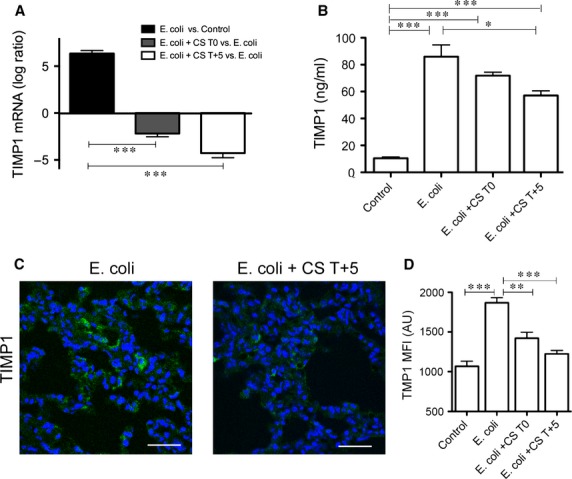
Compstatin inhibits sepsis-induced expression of TIMP1. (A) Log ratio qPCR data showing transcript regulation of TIMP1 by sepsis and complement inhibition. Expression values were normalized by housekeeping gene β-actin. Data are shown as mean ± S.E.M. of three replicates. One-way anova with Dunnett's multicomparison test; ***P < 0.001 as compared to Escherichia coli versus Control ratio. (B) TIMP1 levels in citrated plasma at 24 hrs after challenge with E. coli with/without compstatin treatment during the first (T0) and second (T+5) stages of experimental sepsis. Data are shown as mean ± S.E.M. of three replicates. One-way anova with Dunnett's multicomparison test; ***P < 0.001, *P < 0.05 as compared to Control or E. coli groups. (C) Immunofluorescent staining and semi-quantitative image analysis (D) confirm the induction of TIMP1 by sepsis and the inhibitory effect of compstatin on this protease inhibitor. Magnification: bar, 50 μm. Data are shown as means ± S.E.M.; one-way anova with Dunnett's multicomparison test. ***P < 0.001, **P < 0.01, as compared to the E. coli group.